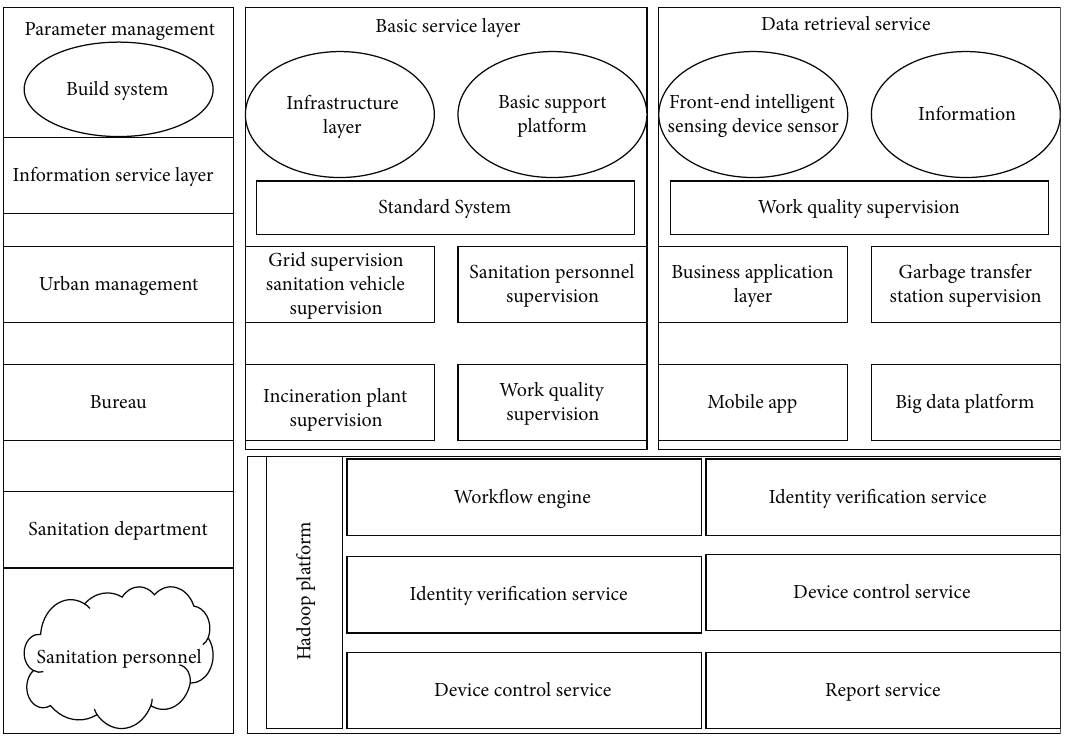
Figure 3: Framework diagram of the solid waste transfer